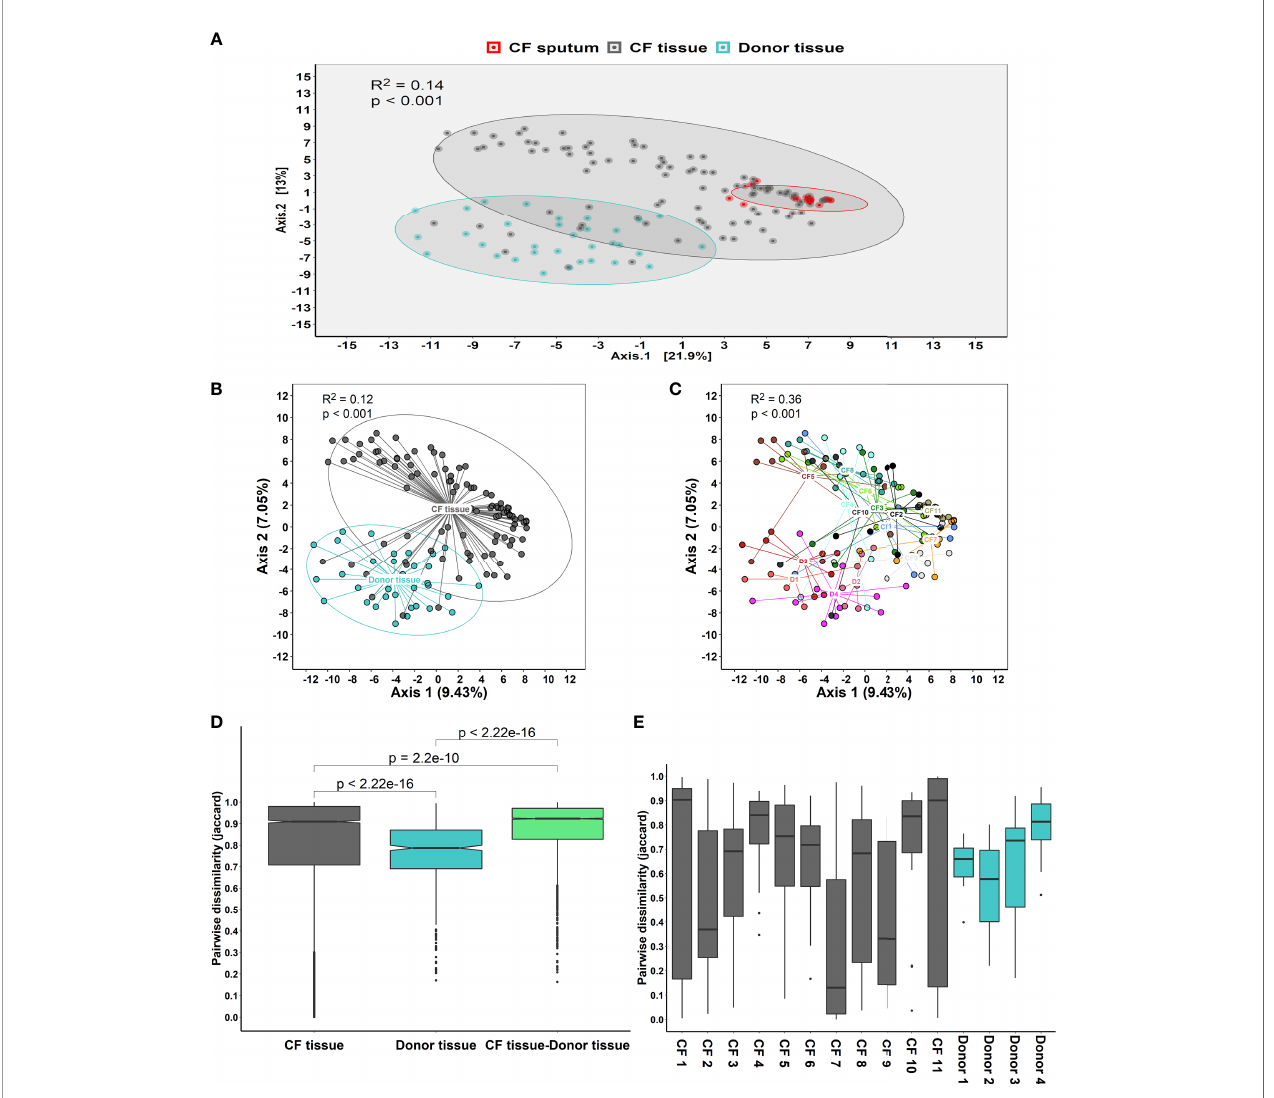
FIGURE 1 | (A) Principal coordinate analysis (PCoA) plot between the three sample cohorts, based on the Euclidean distance metric, adjusted for repeated sampling by patient (adonis analysis [permutational multivariate ANOVA] F=11.55; R 2 = 0.1306; p=0.001; con fi dence based on 90% CI). (B) Analysis of multivariate homogeneity (PERMDISP) tests between CF and donor tissue cohorts to assess signi fi cant differences in median distance to centroid. (C) Analysis of multivariate homogeneity (PERMDISP) tests between individual patients to assess signi fi cant differences in median distance to centroid. Distances to the centroids on the fi rst two PCoA axes showing 90% con fi dence interval. P <0.05 denotes statistical signi fi cance with 999 permutations. (D) Pairwise intra- and inter-dissimilarity (Jaccard ’ s dissimilarity) between tissue cohorts. (E) Intra-dissimilarity (Jaccard ’ s dissimilarity) for samples belonging to individual